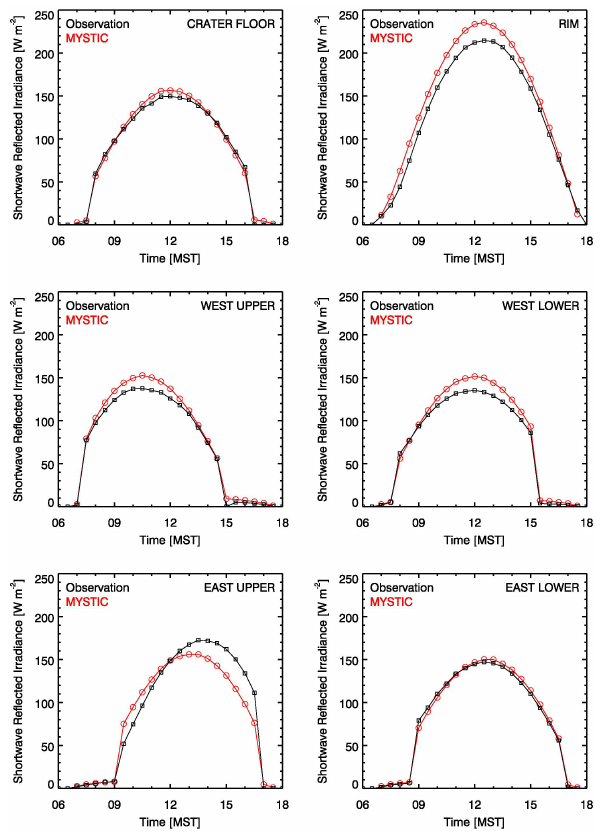
Fig. 8. Observed (black) and modeled (red) albedo at the crater floor and rim sites for 21 October